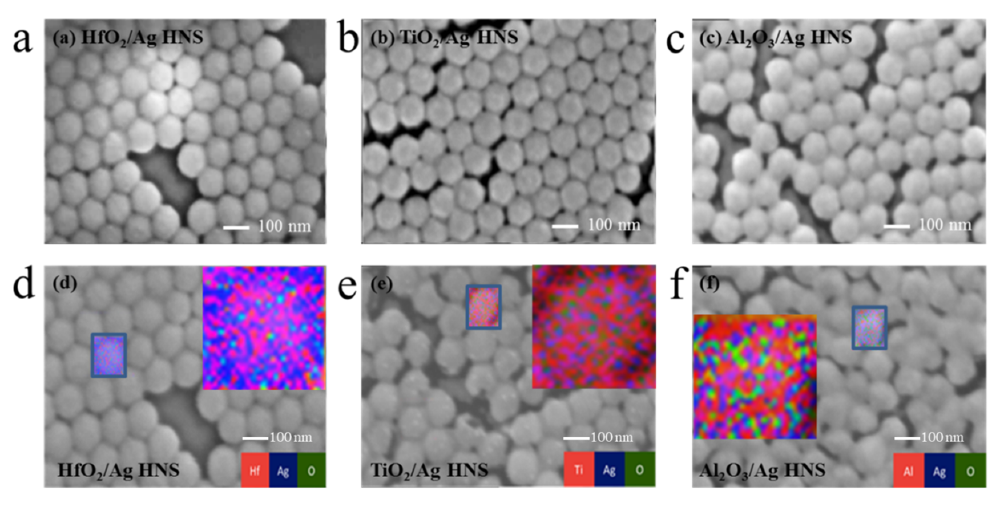
Figure 3. SEM images of Di NPs/Ag HNS_130: ( a ) HfO 2 /, ( b ) TiO 2 /, and ( c ) Al 2 O 3 /Ag HNS with the magnification of 90,000×. The uniform arrangement of dots represents that different Di NPs were arranged on Ag HNS surface. The EDS mappings of ( d ) HfO 2 /, ( e ) TiO 2 /, and ( f ) Al 2 O 3 /Ag HNS were shown with a scanned area of single Ag HNS. It demonstrated aligned bulges, corresponding to Di NPs upon Ag HNS.